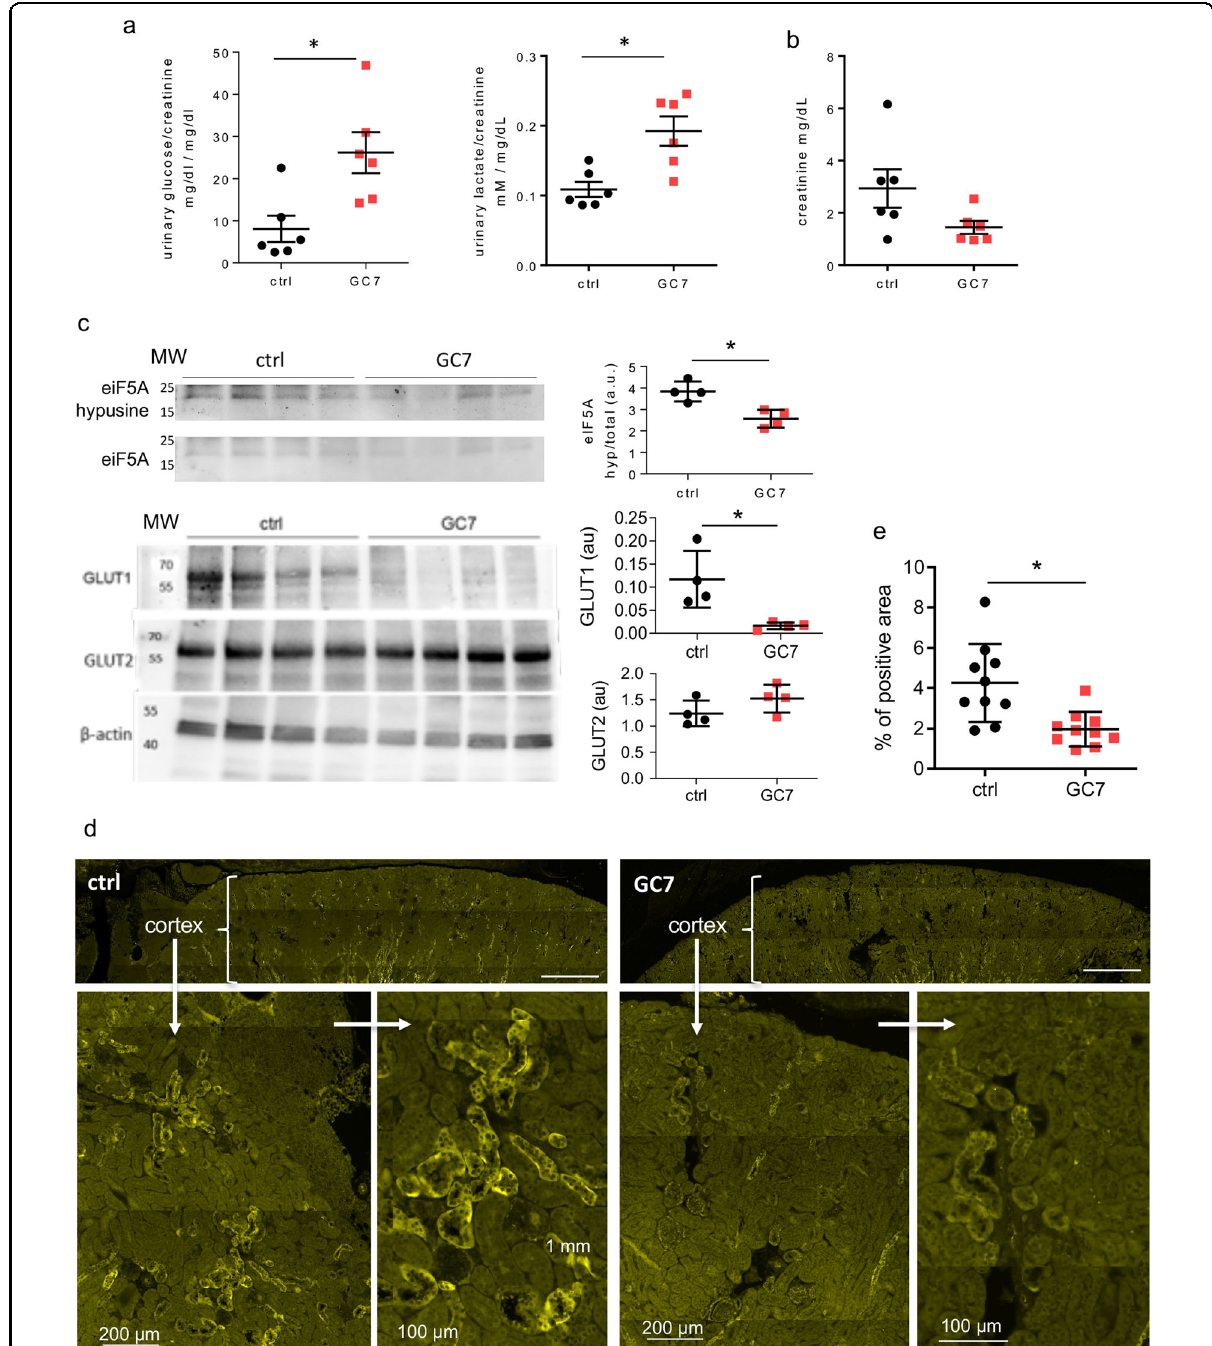
Fig. 7 Impact of a 3-days GC7 treatment on kidney glucose metabolism. Mice were treated 3 days with GC7 (3 mg/kg, i.p., “ GC7 ” group) or vehicle only (NaCl, “ ctrl ” group) and metabolic parameters were analysed at the end of the treatment. a Glucosuria (glucose/creatinine) and lactaturia (lactate/creatinine) measured in bladder urine. b Urinary creatinine (mg/dL). c Hypusination of eIF5A and GLUT1 and GLUT2 protein levels evaluated by western blot using four kidney protein extract for each group. MW molecular weight. Graphic displayed hypusine/total eIF5A ratio and GLUT/ β -actin ratio using optical density band values. d Mosaic reconstruction of whole-kidney sections from untreated and GC7-treated mice displaying GLUT1 signals in the cortical region. Magni fi cation of a representative cortical regions from each group. Scale bars are indicated. e Quanti fi cation of GLUT1 immuno fl uorescence. Graphics displayed the scatter plot of 4 ( c ), 6 ( a , b ) or 10 ( e ) independent values and mean ± SD. * p < 0.05 evaluated using Mann – Whitney